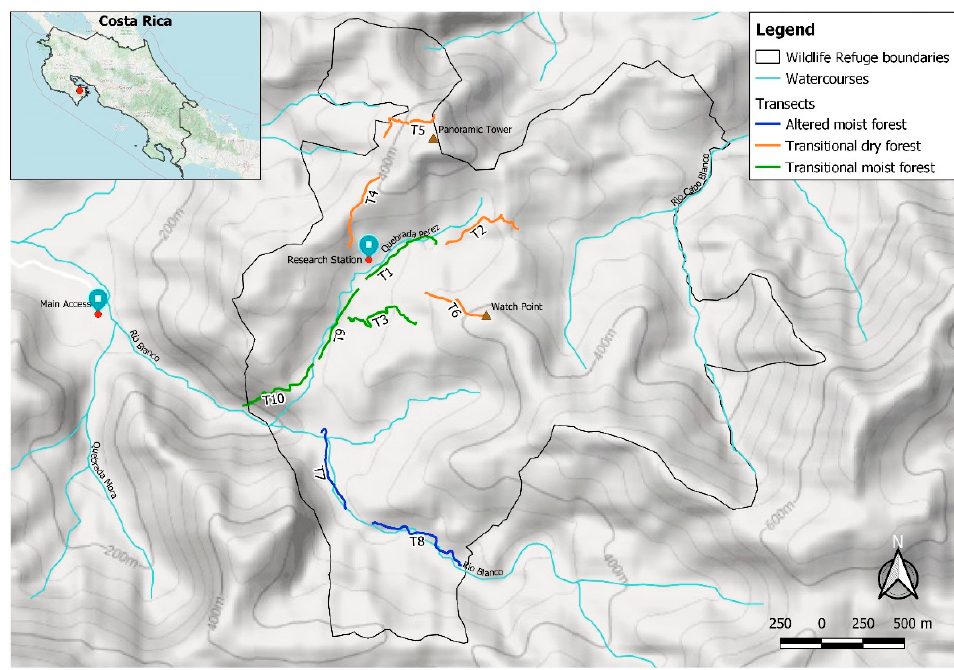
Figure 2. Map of the Karen Mogensen Wildlife Refuge (Costa Rica) with highlighted transects (T1 to T10), watercourses and points of interest. Transects are colored according to the habitat. “Primary transitional moist forest” corresponds to Stratum A (in green), while “Secondary transitional dry forest” corresponds to Stratum B (in orange). “Altered moist forest” transects, which were not considered in the habitat analysis, are shown and correspond to Stratum C (in blue). Map created with software QGIS v. 2.18.